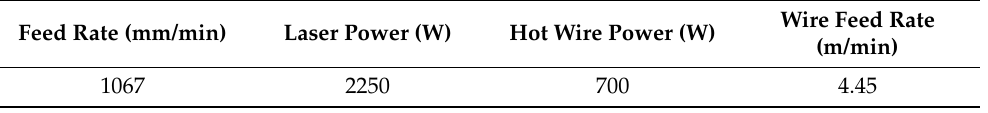
Table 2. Sample part deposition parameters.